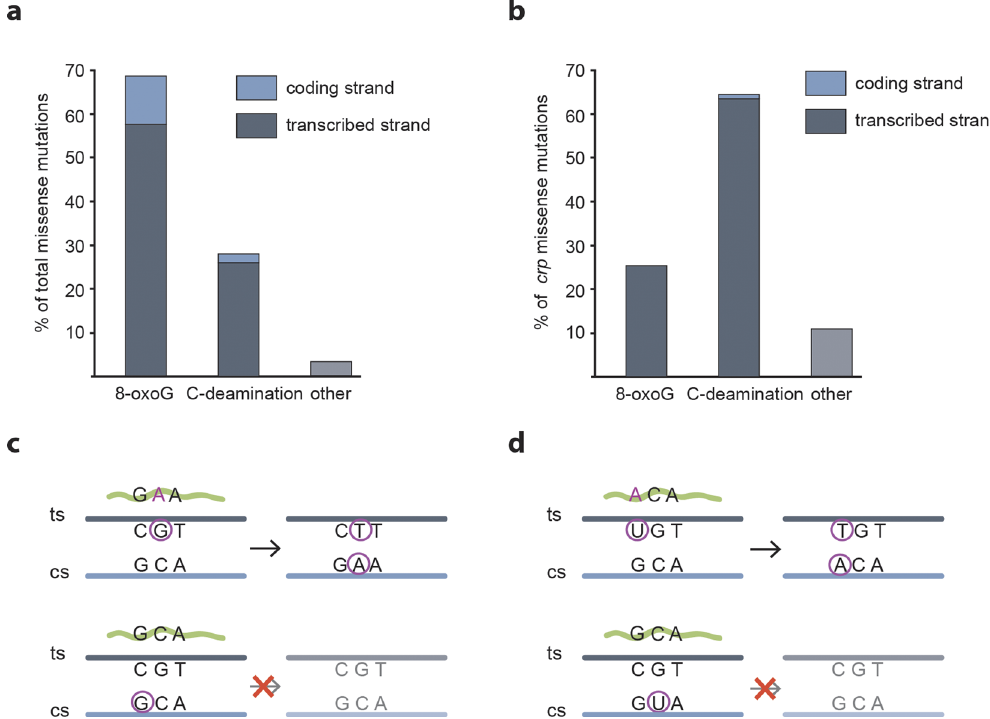
Figure 3. 8-oxoguanine formation and cytosine deamination are highly dominating on the transcribed strand in isolated papillae. ( a ) Assuming that all identified G-T and C-A transversions are the result of 8-oxoguanine formation, and all G-C to A-T transitions are the result of cytosine deamination, we analysed the localisation of the corresponding G- and C- residues in the 96 sequenced mutant genomes and in ( b ) the 594 sequenced crp sequences. Only missense mutations were analysed. ( c ) Upper panel: Illustration of the mechanism of retromutagenesis after 8-oxoguanine (encircled G) formation on the transcribed strand (ts, dark grey line) that enables insertion of an adenine ribonucleotide in the mRNA (green waved line). The mutated mRNA enables growth and a round of replication that permanently fixes the mutation on the coding strand (cs, light blue line) in daughter cells. Lower panel: 8-oxoguanine formation on the coding strand does not transfer to daughter cells. ( d ) Illustration of retromutagenesis after cytosine nucleotide deamination into uracil (encircled U), enabling base pairing with A. Upper and lower panels show result of cytosine deamination on transcribed and coding strand respectively, as detailed in ( c